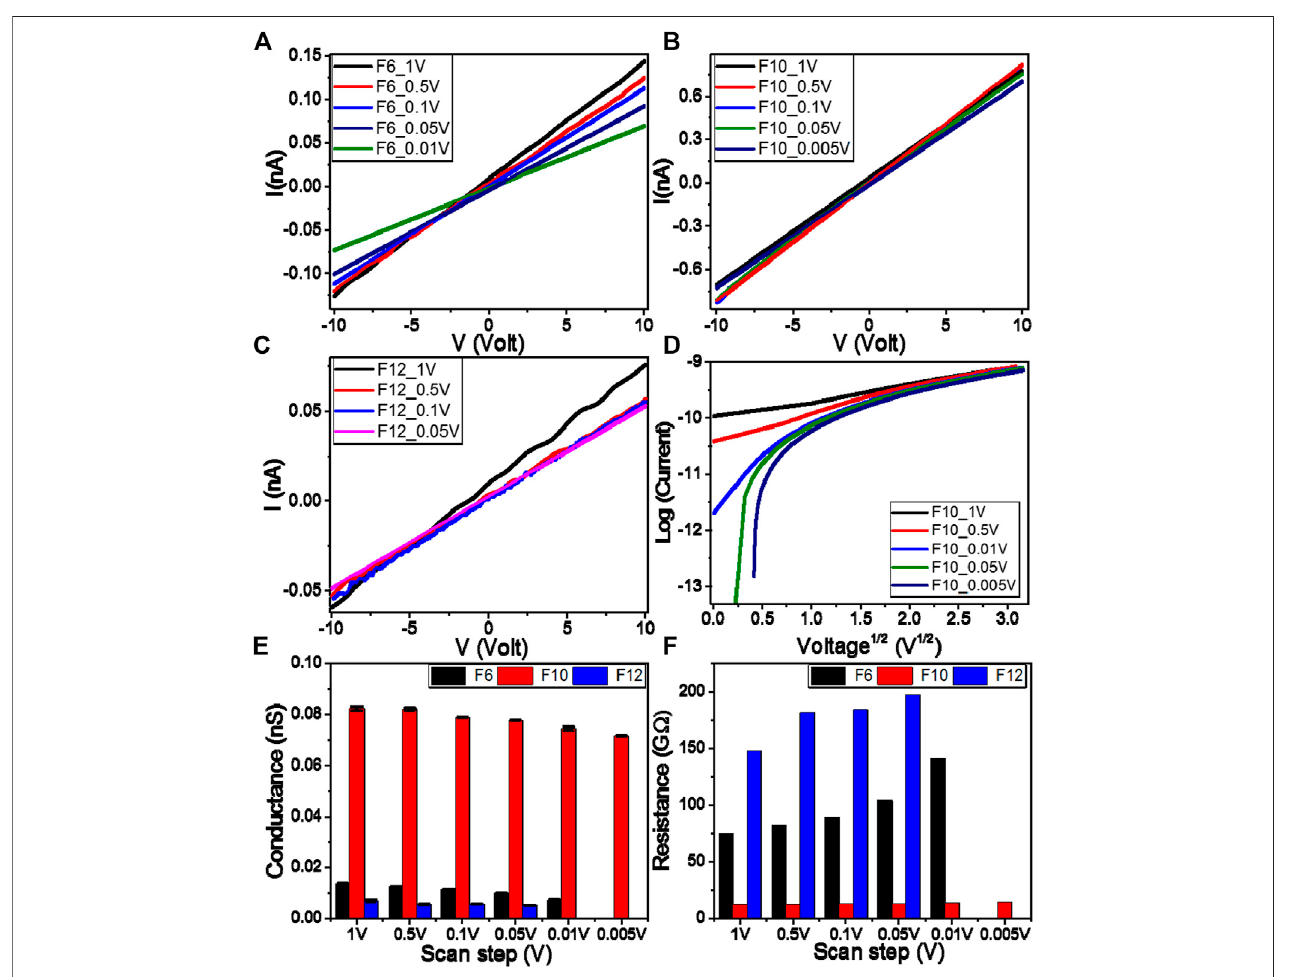
FIGURE 4 | Electrical voltage – current characteristics of (A) F 6 (B) F 10 , and (C) F 12 samples (D) Log(I) vs. V 0.5 for F 10 samples (E) electric conductance and (F) electric resistance at different scan steps for samples F 6 , F 10 , and F 12 .